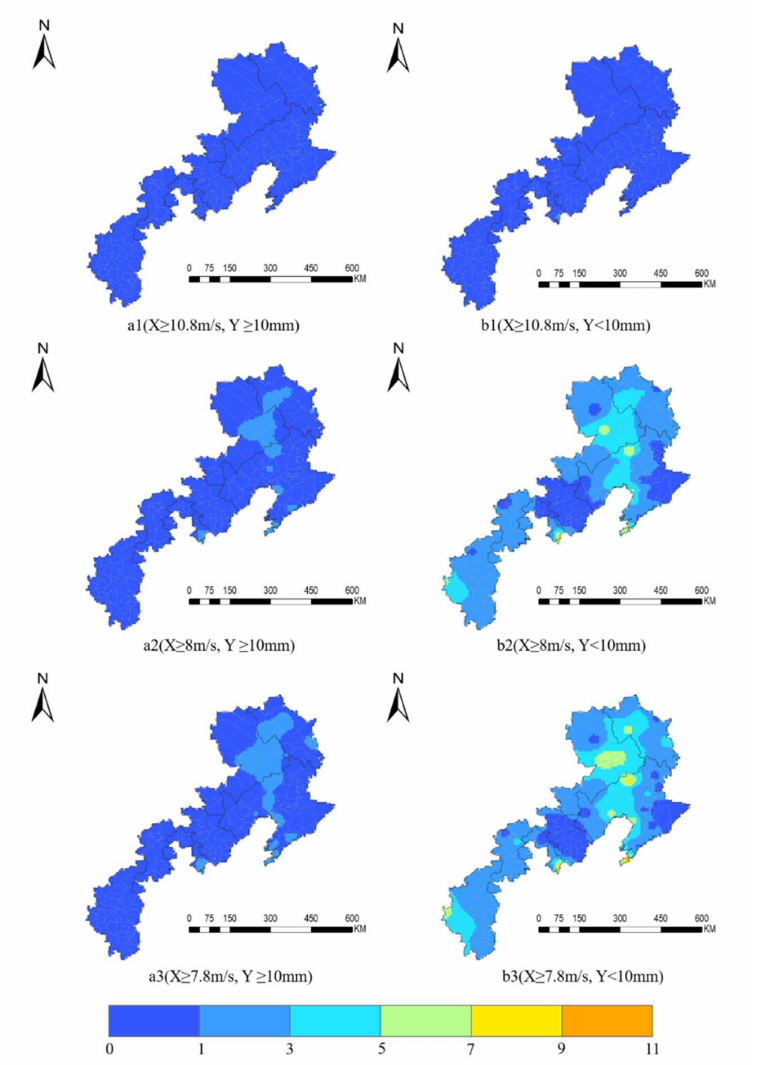
Figure 8. Spatial distribution of the maize root and stalk lodging level. Levels 0 to 11 are lodging occurrence times in the sensitive growth stage, while the lodging degree is partial and above, “a” series represent the distribution of maize root lodging, “b” series represent the distribution of maize stalk lodging, and X and Y, respectively, represent the maximum daily wind speed and